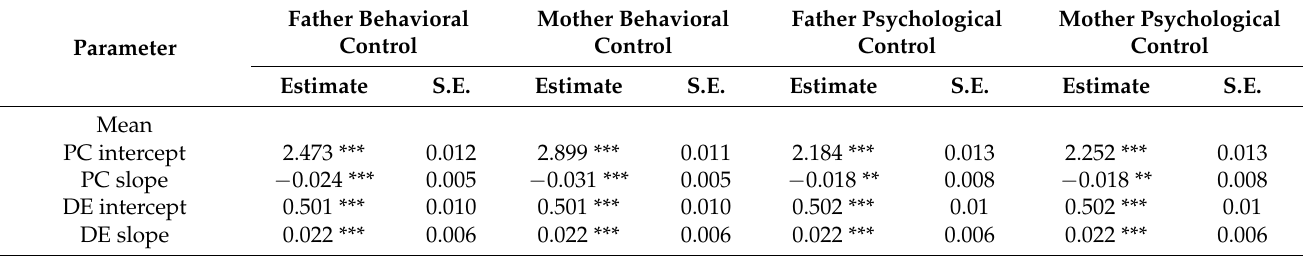
Table 1. Parameter estimates and model fit for the parallel-process latent growth curve models (PP-LGCMs).